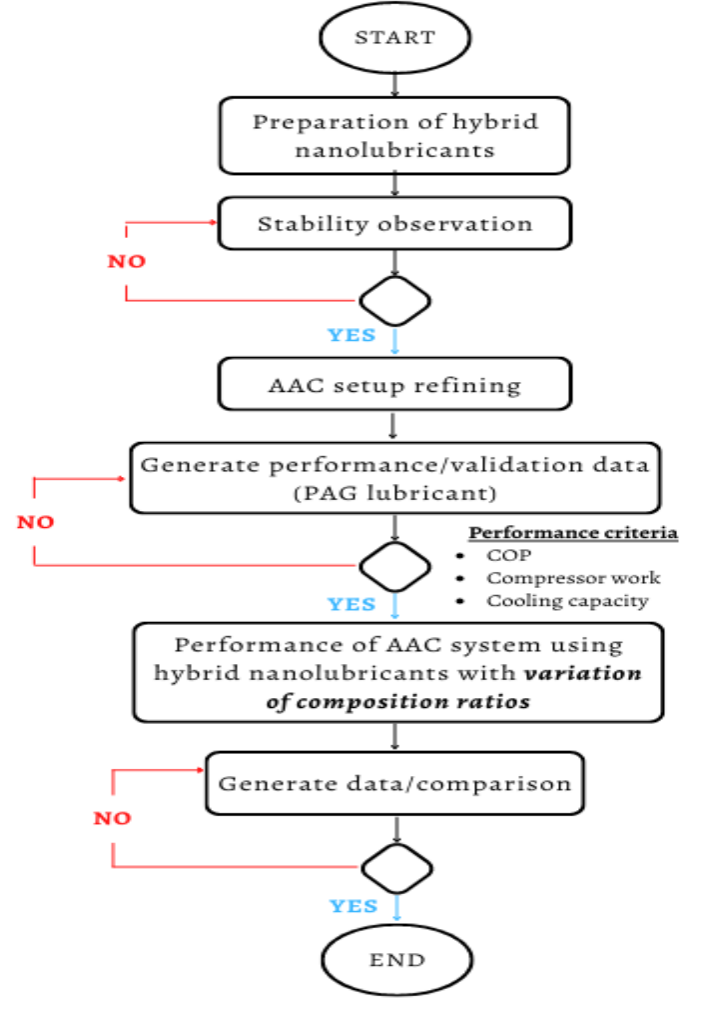
Figure 5. AAC system process flow chart.